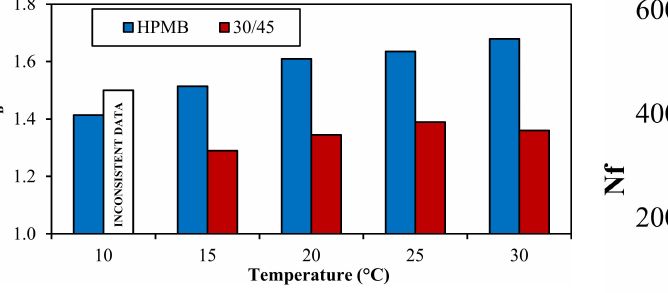
Figure 4: Fatigue area factor results